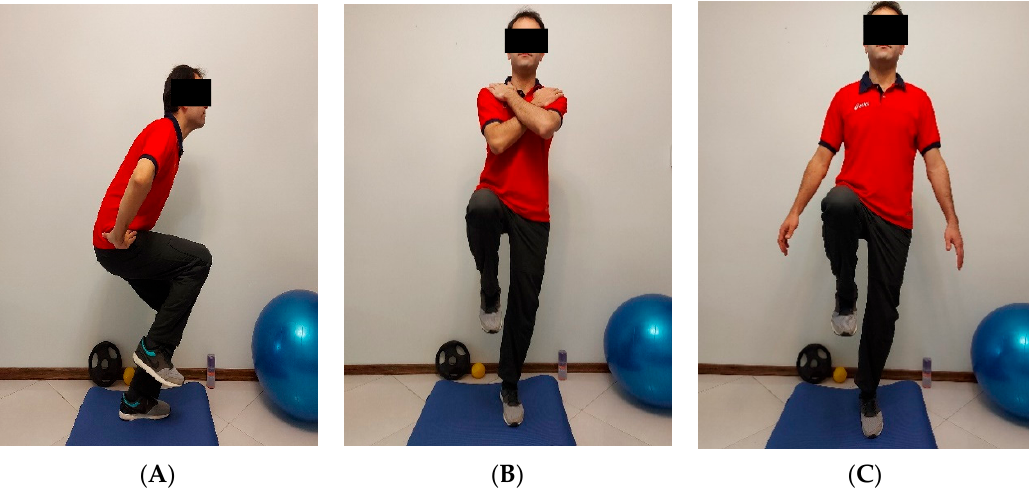
Figure 2. How to perform the move of the single leg squat airex, eyes closed, hands on the hips ( A ); single leg stance, airex, eyes closed, arms crossed ( B ) and single leg stance, airex, eyes closed, arms free ( C ).